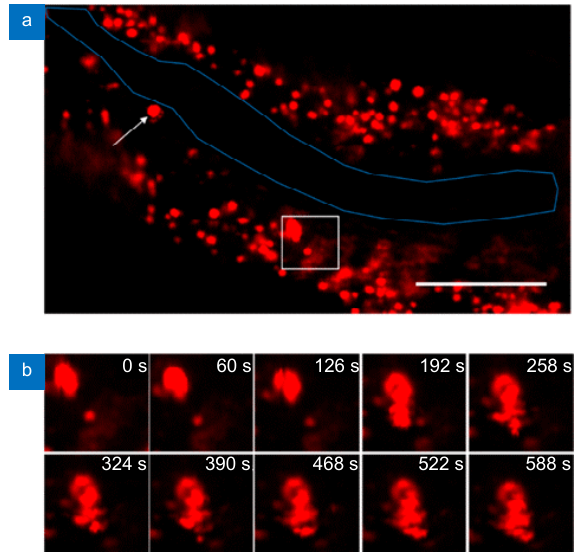
Fig. 9 | Transient absorption imaging of heme granule dynam- ics in C. elegans. ( a ) Image of C. elegans at time zero, arrow: heme granule, blue line: worm intestinal membrane outline, the scale bar is 40 μ m. ( b ) Enlarged view of heme granule in the white box of (a) at different time points. Figure reproduced from: ref. 239 , American Society of